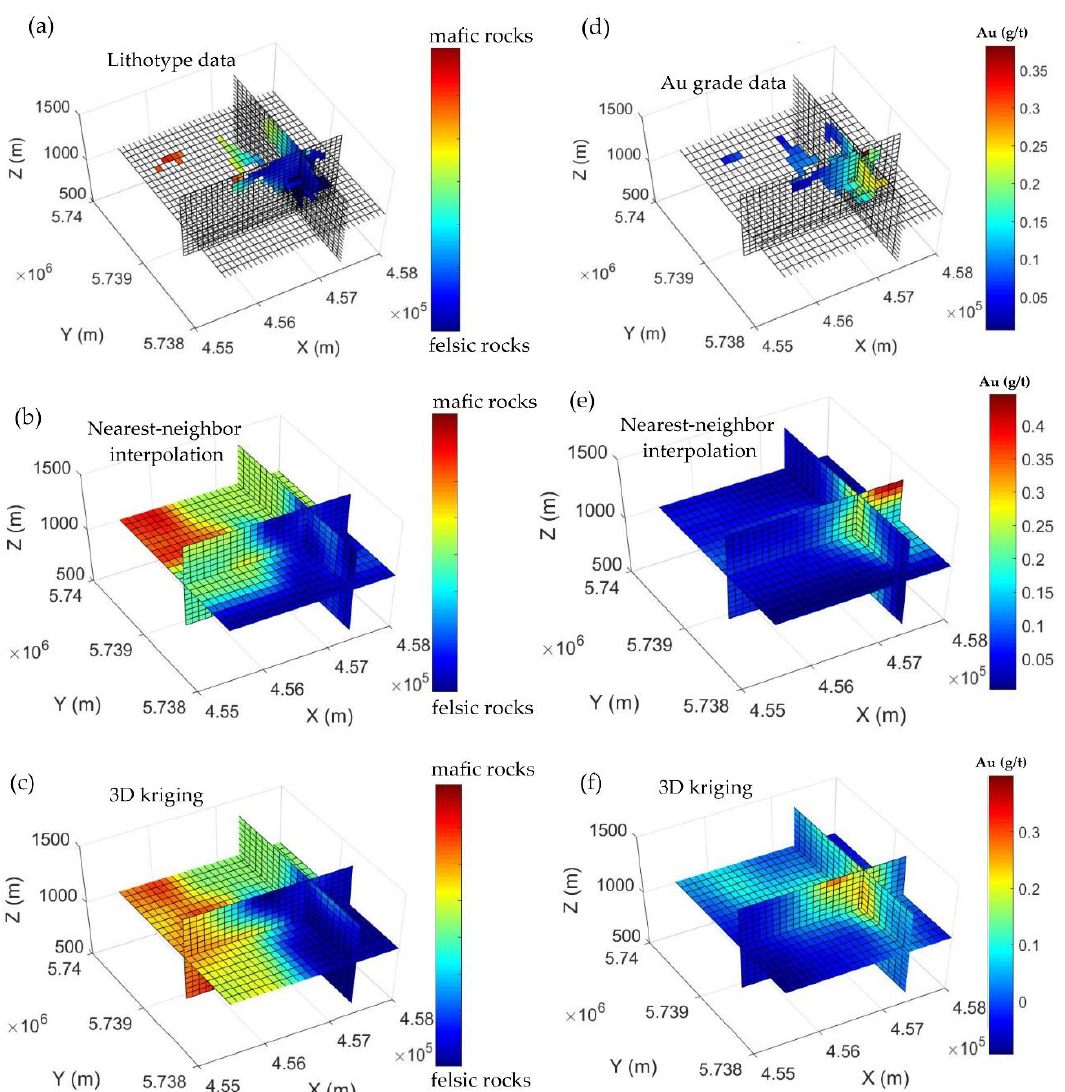
Figure 5. Interpolation of geological targets with conventional methods. ( a ) Lithotype data (mafic/felsic). ( b ) Nearest-neighbor interpolation of lithotypes. ( c ) Kriging of lithotypes. ( d ) Au grade data. ( e ) Nearest-neighbor interpolation of Au grades. ( f ) Kriging of Au grades [27].